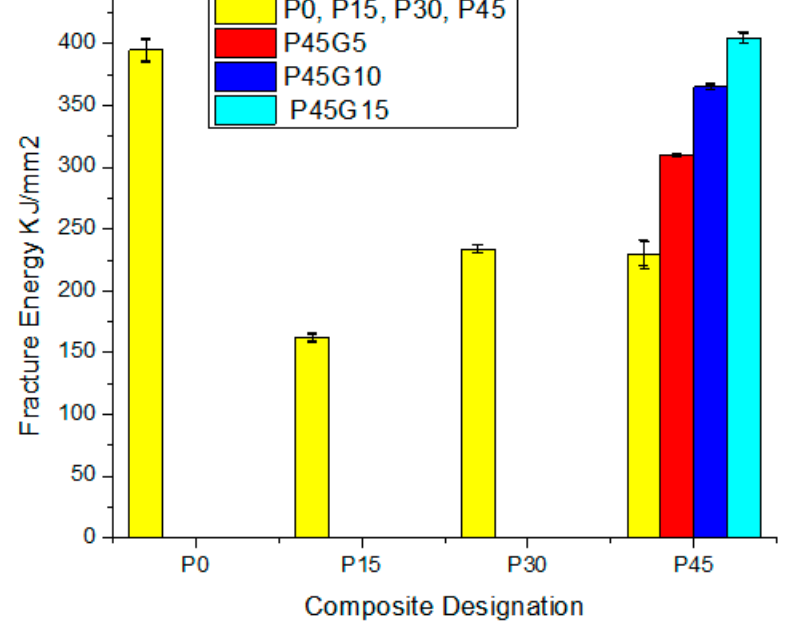
Figure 12. Fracture energy dependency on composite designation.